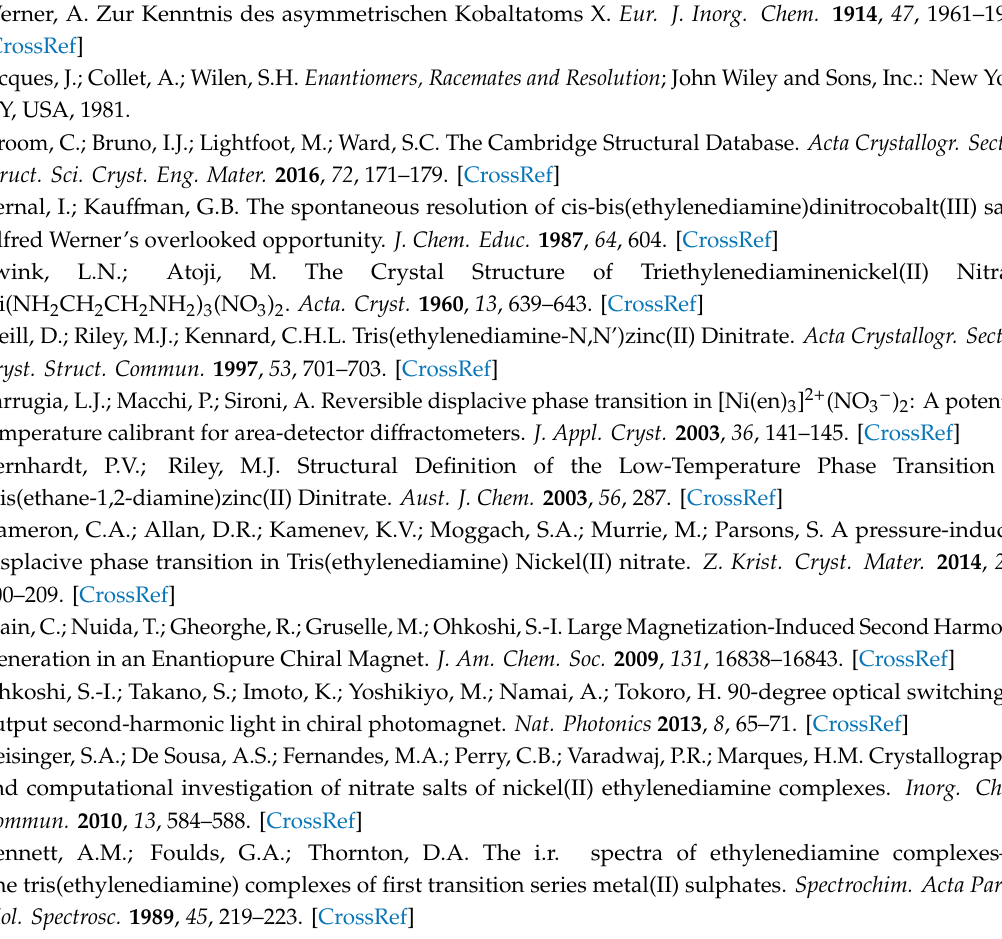
Figure S1. Cation-anion close contacts shown in Λ -[Co(en) 3 ](NO 3 ) 2 at 298 K. Figure S2. Powder X-ray di ff ractograms for [Co(en) 3 ](NO 3 ) 2 at 12 and 300 K; Powder di ff ractograms simulated from ∆ -[Mn(en) 3 ](NO 3 ) 2 single crystal data at 120 and 300 K. Figure S3. Heat capacity trace for [Co(en) 3 ](NO 3 ) 2 . Figure S4. Magnetic behavior of [Mn(en) 3 ](NO 3 ) 2 . Figure S5. Magnetic behavior of [Ni(en) 3 ](NO 3 ) 2 . Figure S6. Magnetic behavior of [Co(en) 3 ](NO 3 ) 2 . Figure S7. X-band (9.54 GHz) EPR of [Co(en) 3 ](NO 3 ) 2 at 5 K. Protocol for Bragg peak examination and Figure S8. Variation of selected Bragg peaks with temperature. Figure S9. Variable temperature Raman spectra measured on a single crystal of [Co(en) 3 ](NO 3 ) 2 between 200 and 100 K. Figure S10. Variable temperature Raman spectra measured on a single crystal of [Mn(en) 3 ](NO 3 ) 2 between 298 and 140 K. Figure S11. Variable temperature Raman spectra measured on a single crystal of [Zn(en) 3 ](NO 3 ) 2 between 200 and 100 K. Figure S12. Comparison of Raman spectra calculated for [Zn(en) 3 ] 2 + from the optimized structures in D 3 and C 2 symmetries. Figure S13. Comparison of Raman spectra measured at 100 K and calculated for [Zn(en) 3 ] 2 + and [Zn(en) 3 ](NO 3 ) 2